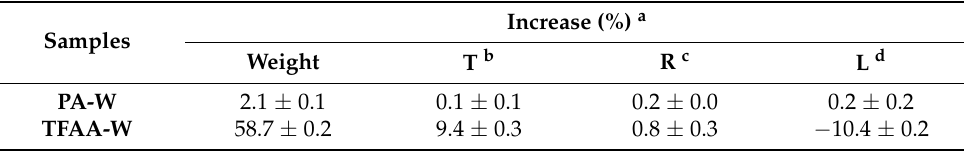
Figure 1. Photographs of degreased and propionylated wood samples. Table 2. Increase in the weight and length of each side of the propionylated wood samples relative to the degreased wood